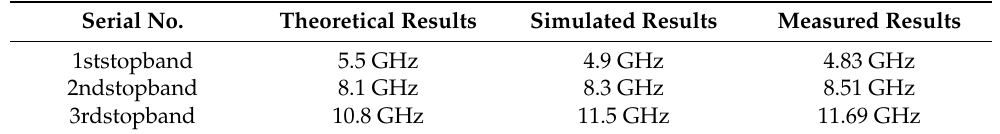
Table 4. Results variation of the Table 3. Calculated properties of the stopbands.